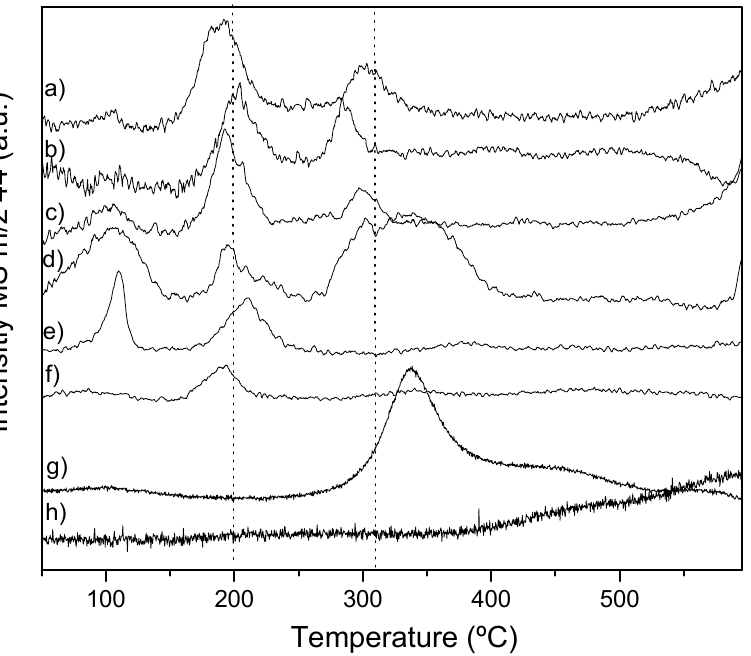
Figure 5. CO 2 -TPD profiles. ( a ) CuMo x C/H-700, ( b ) CuMo x C/H, ( c ) CuMo x C/H-550, ( d ) CuMo x C/H-500, ( e ) CuMo x C/rGO, ( f ) CuMo x C/CNT, ( g ) Cu/H and ( h ) Mo x C/H.